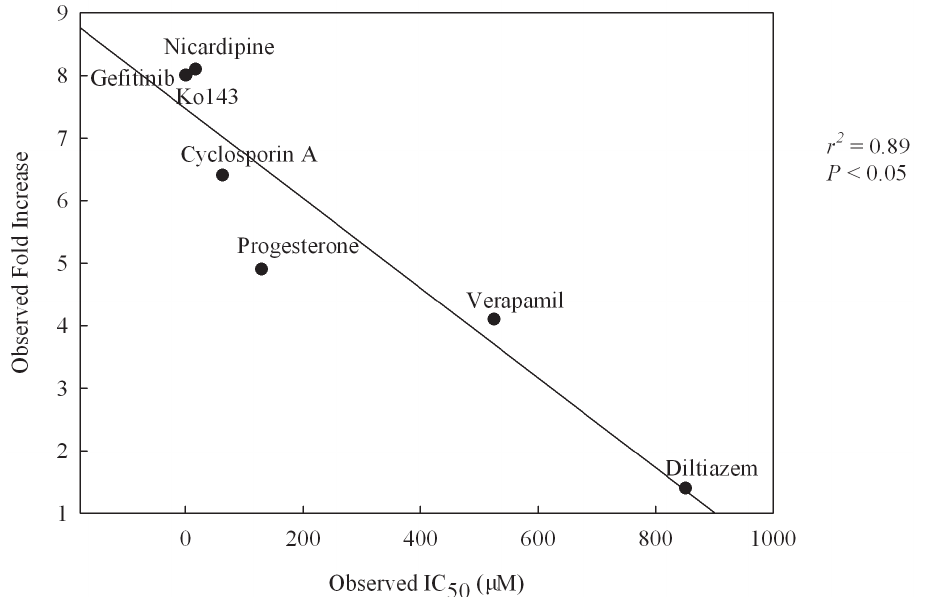
Figure 9. Observed fold increase vs . observed IC 50 . Experimental fold increase of BCRP inhibition measured in Saos-2 cells vs . observed IC 50 measured in MCF-7 MX cells.